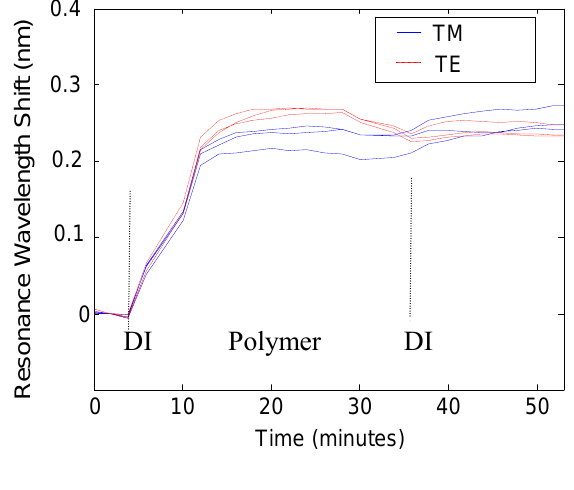
Figure 8. Dual polarization resonance response for poly (allylamine hydrochloride) binding to the sensor showing resonance wavelength shift as a function of time.